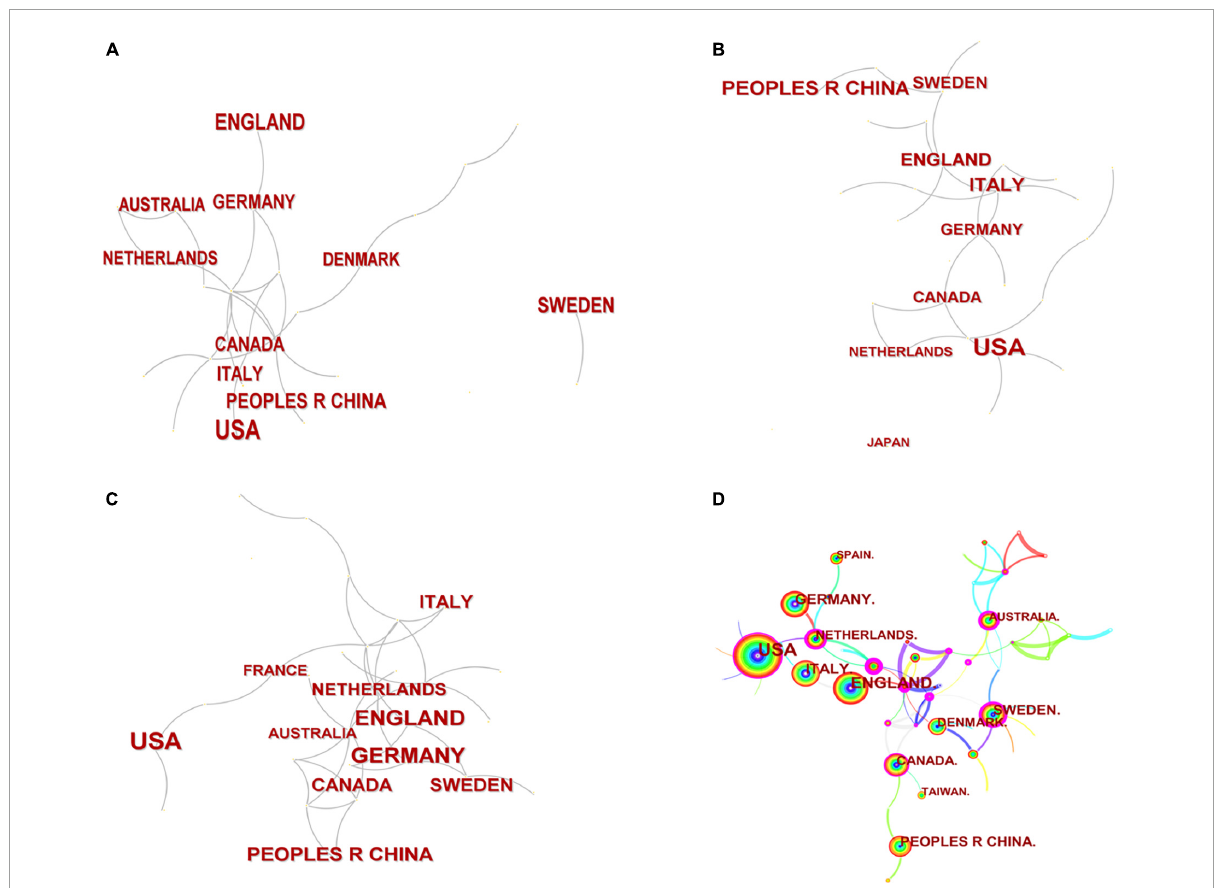
FIGURE3 A country/region cooperation map related to Tourette Syndrome (TS) in children research from 2019 (A) , 2020 (B) , 2021 (C) and from 2011 to 2021 (D) .